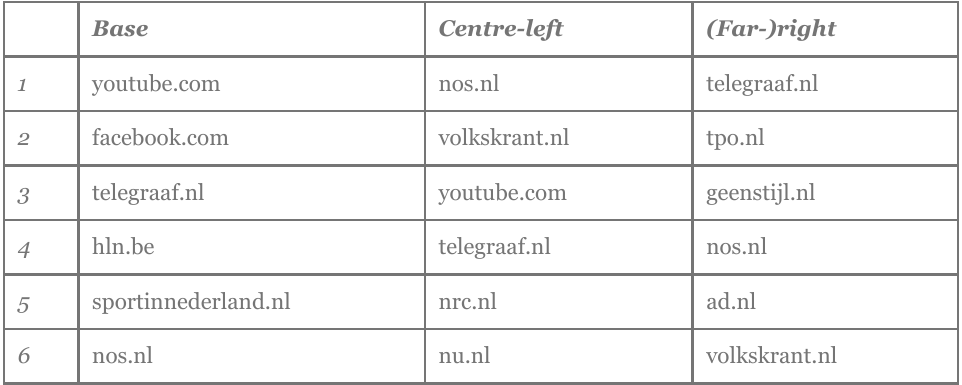
Fig. 3. Distribution of top six linked domain names across clusters/entire graph. Base Centre-left